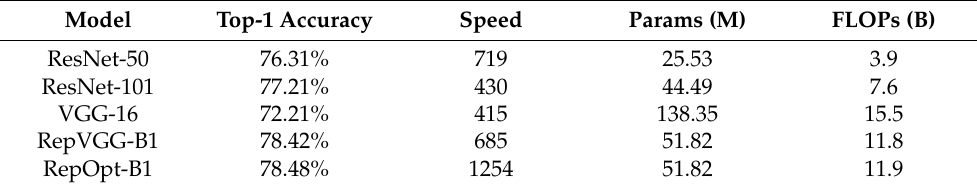
Table 2. Accuracy and training speed on ImageNet dataset (1080Ti BS =